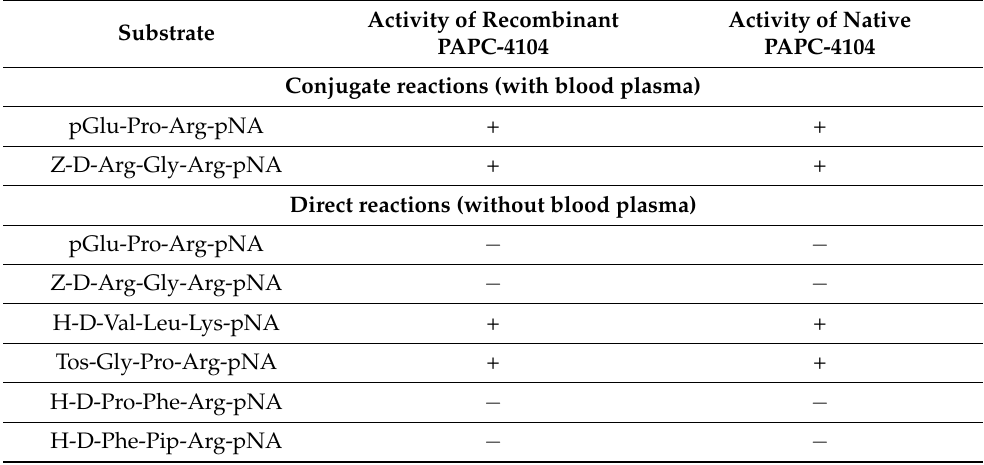
Table 1. Substrate specificity of recombinant and native PAPC with chromogenic peptide substrates. If measured values of A 405 of a quantitative reaction exceeded 0.1, the substrate specificity of enzyme is estimated as positive (“+”); if not, as negative (“ −